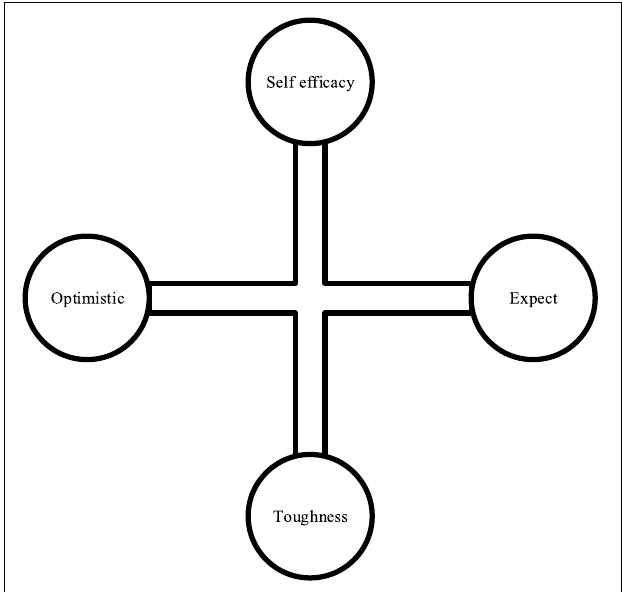
FIGURE 1 | Dimensions of entrepreneurial